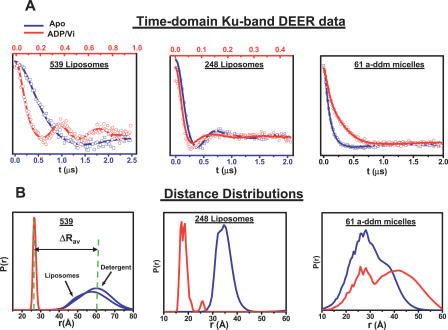
Representative Distance Changes in MsbA Induced by ATP Hydrolysis(A) Ku-band (17.3 GHz) DEER signals at representative sites illustrating the change in the signal induced by the transition from the apo state to the ADP/Vi intermediate. (B) In this transition, distance distributions P(r) for sites 539 and 248 become narrow, with average distances showing large negative shifts; whereas for site 61, the shift is large and positive. Time-domain DEER signals and details of distance analysis are further illustrated in Figures S1–S5 supplementary material. The broad distance distribution at site 61 indicates a highly flexible loop. The distance change at this site in liposomes (even though it is very similar to that in detergent) may indicate a shift in the relative population in a bimodal distribution (Figure S1) although further work would be required to substantiate this result. In the samples of ADP/Vi intermediates, a small fraction of MsbA in the apo state is also present; and as a result, a low-intensity component in the P(r), corresponding to this state, is visible in this case and is larger in lipid. (These satellites are suppressed for sites 248 and 539 in (B).) For site 61, the lines overlap and are displayed as is, but they are shown separated in the supplement. a-ddm: alpha dodecyl maltoside.